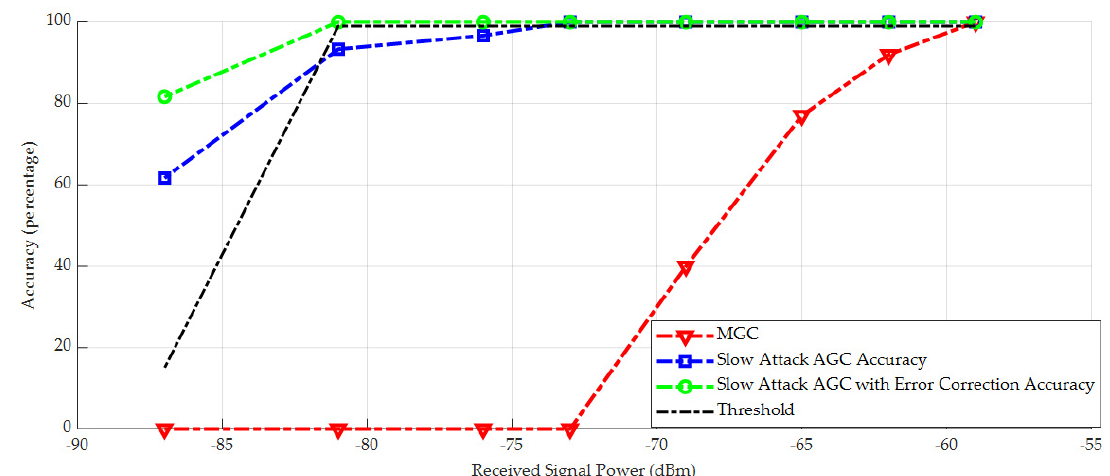
Figure 13. Measured accuracy for various modes.